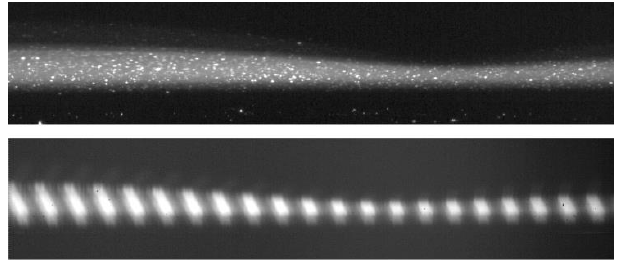
Figure 5. Raw PIV image ( above ) and SPLIF image ( below ). The two images here do not rigorously represent the same state of a capillary wave.